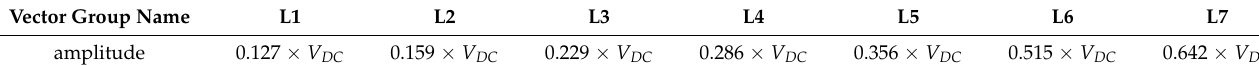
Table 1. Switching vector amplitudes.